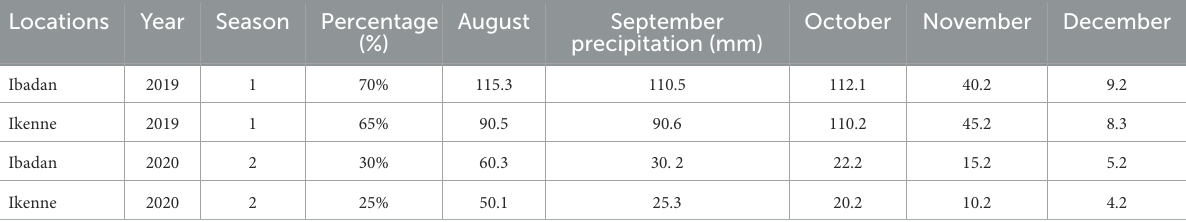
TABLE 1 Rainfall distribution pattern in both locations and seasons.